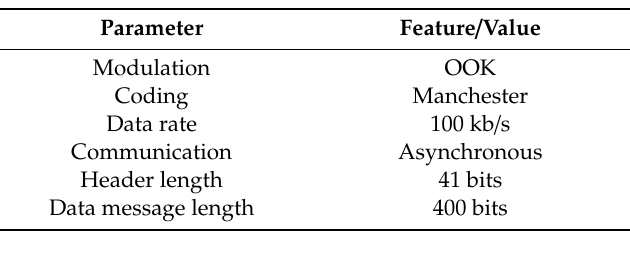
Table 1. Summary of the simulation parameters.